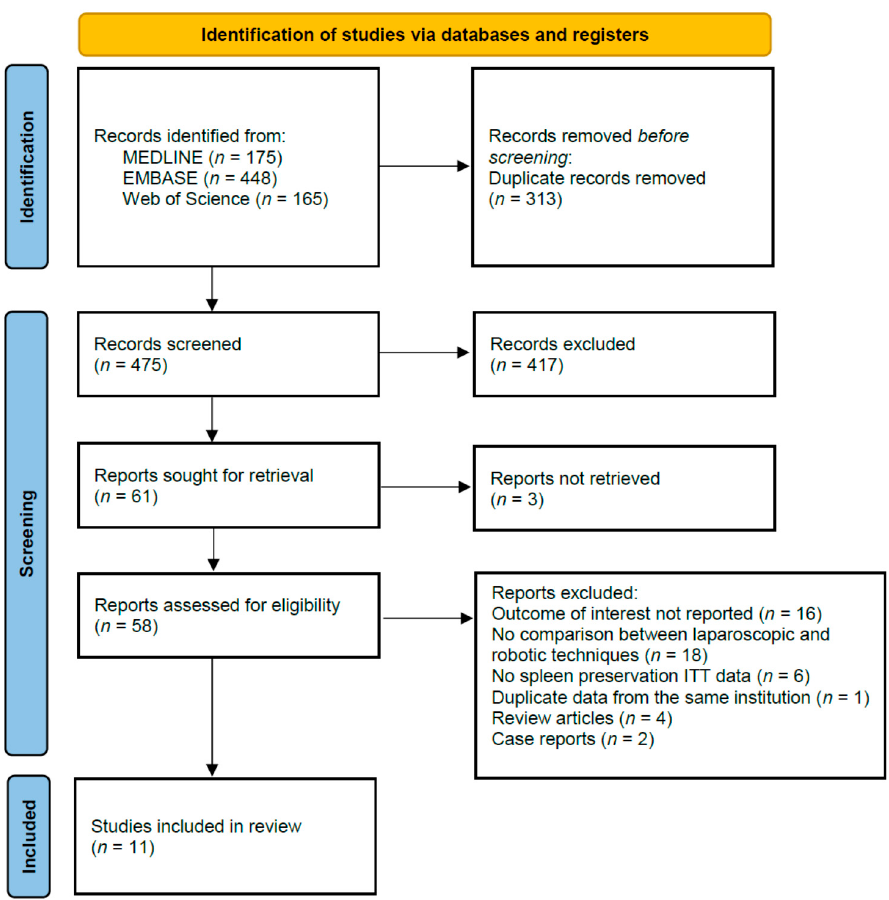
Figure 1. PRISMA flow diagram. ITT: intention-to-treat.